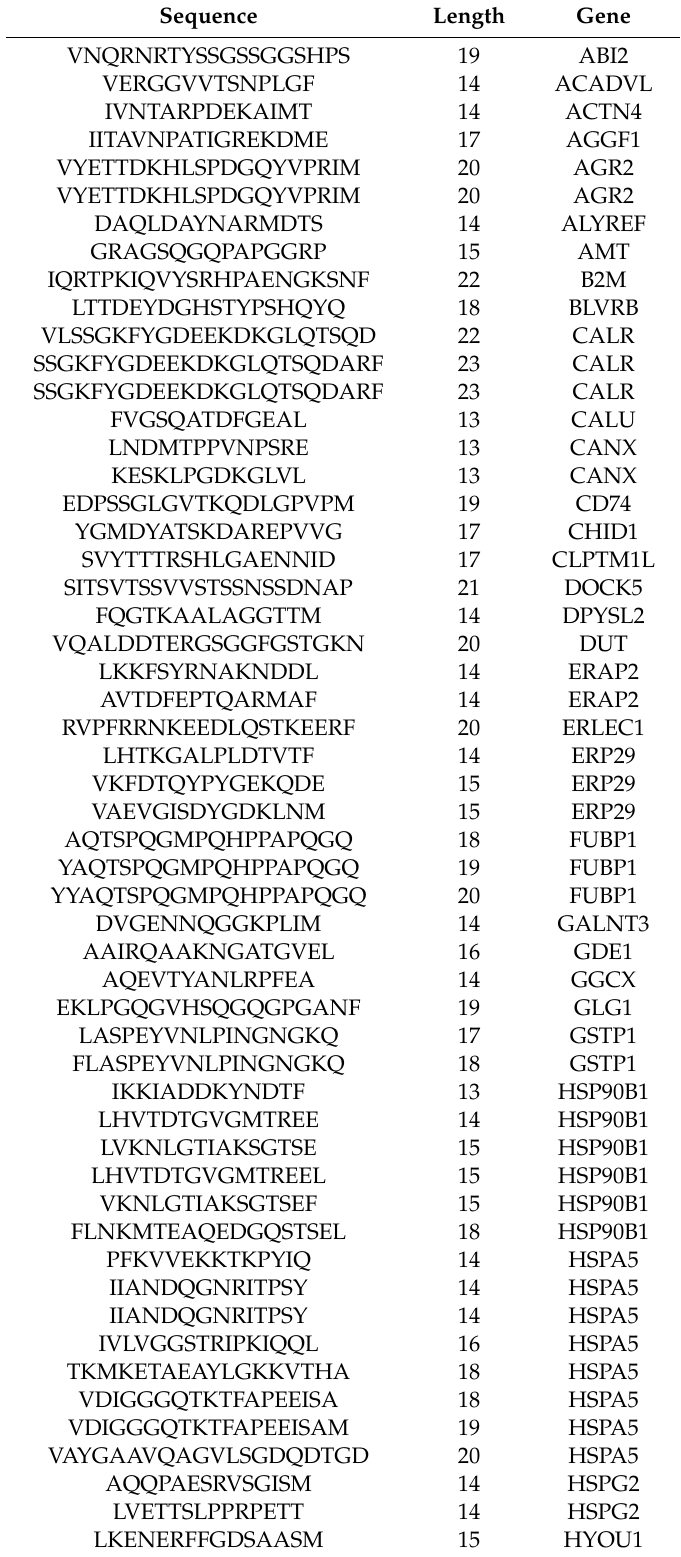
Table 4. MHC-II bound peptides from OVCAR8 cell